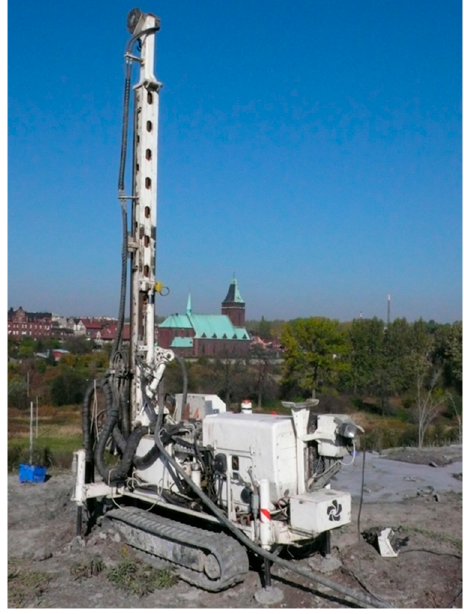
Figure 16. Low-pressure injection unit (by Ł ukasz Wójcik).